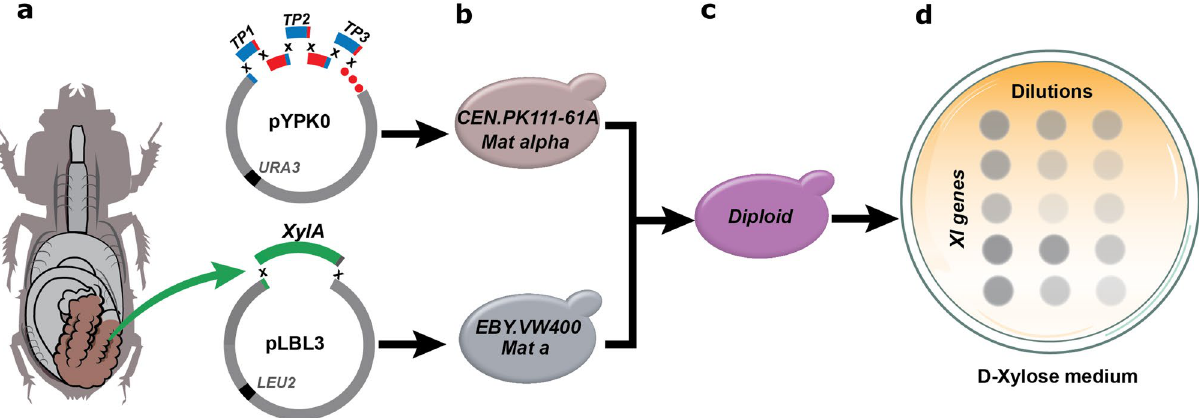
Figure 1. Strategy for the screening of d-xylose isomerases (XIs) in Saccharomyces cerevisiae . ( a ) Putative xylA genes from the microbial metagenome in the gut of a passalid beetle ( Odontotaenius disjunctus ) were codon- optimized, synthesized and cloned in the plasmid pLBL3; the partial d-xylose pathway ( TKL1 , TAL1 , RPE1 , RKI1 , XKS1 , and Gxf1) was constructed in the plasmid pYPK0 under the control of different terminators/ promoters (TP). ( b ) The plasmids containing xylA genes (pLBL3_XI) were carried by the strain EBY.VW400 and the plasmid containing the partial d-xylose pathway (pYPK0_XTTRRG) was carried by the strain CEN. PK111-61A. ( c ) Each EBY.VW4000 strain clone was mated with the CEN.PK111-61A strain. ( d ) Candidate XI enzymes were functionally screened by scoring yeast growth on solid media with d-xylose as the sole or main carbon